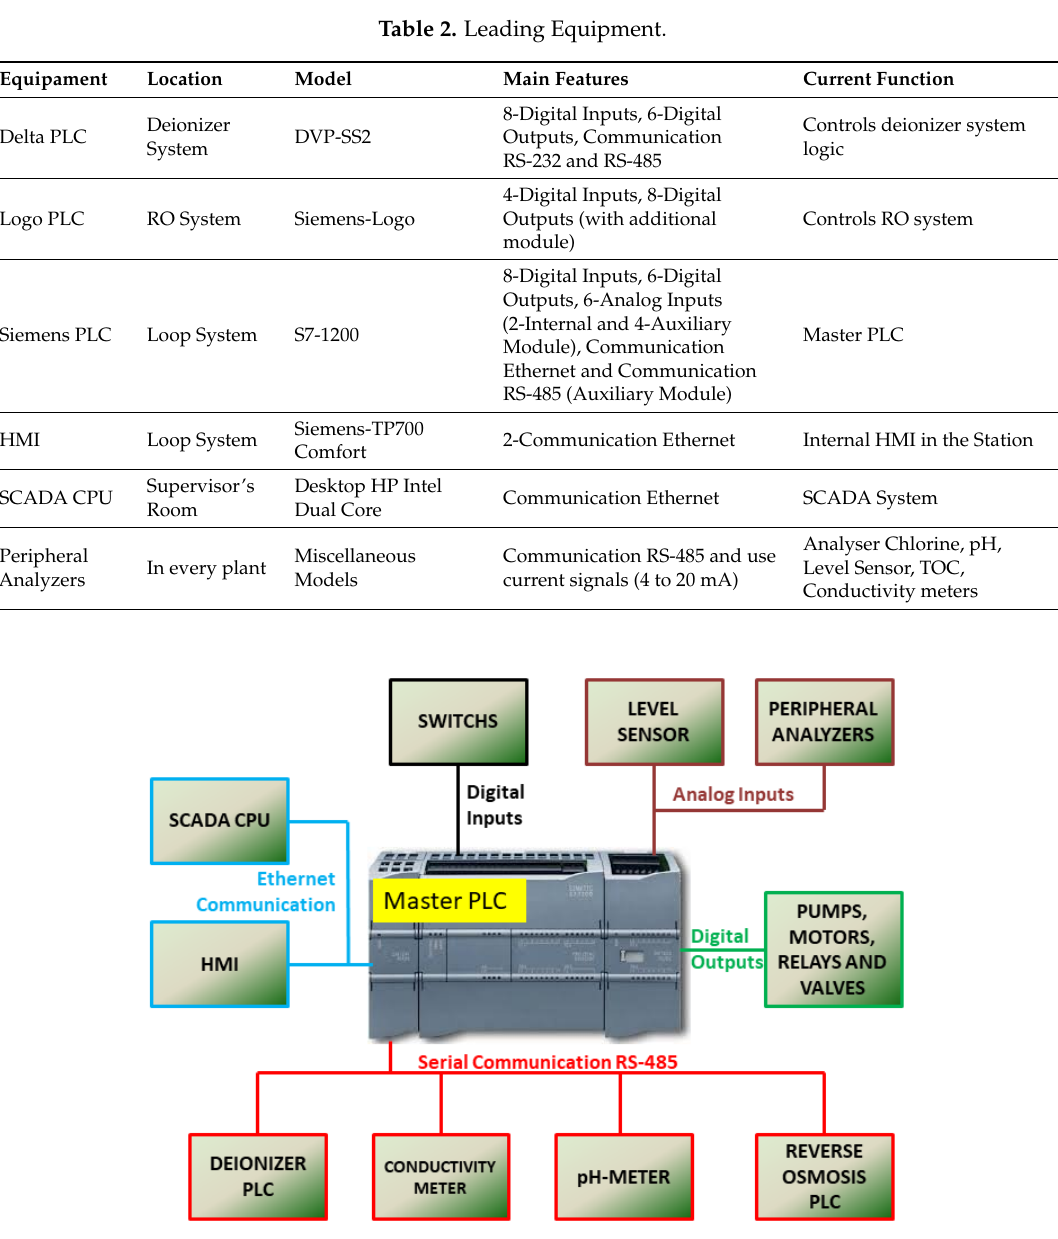
Figure 7. Automation system after interconnection of